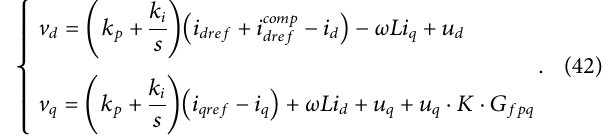
Figure 11 of the current loop control system with